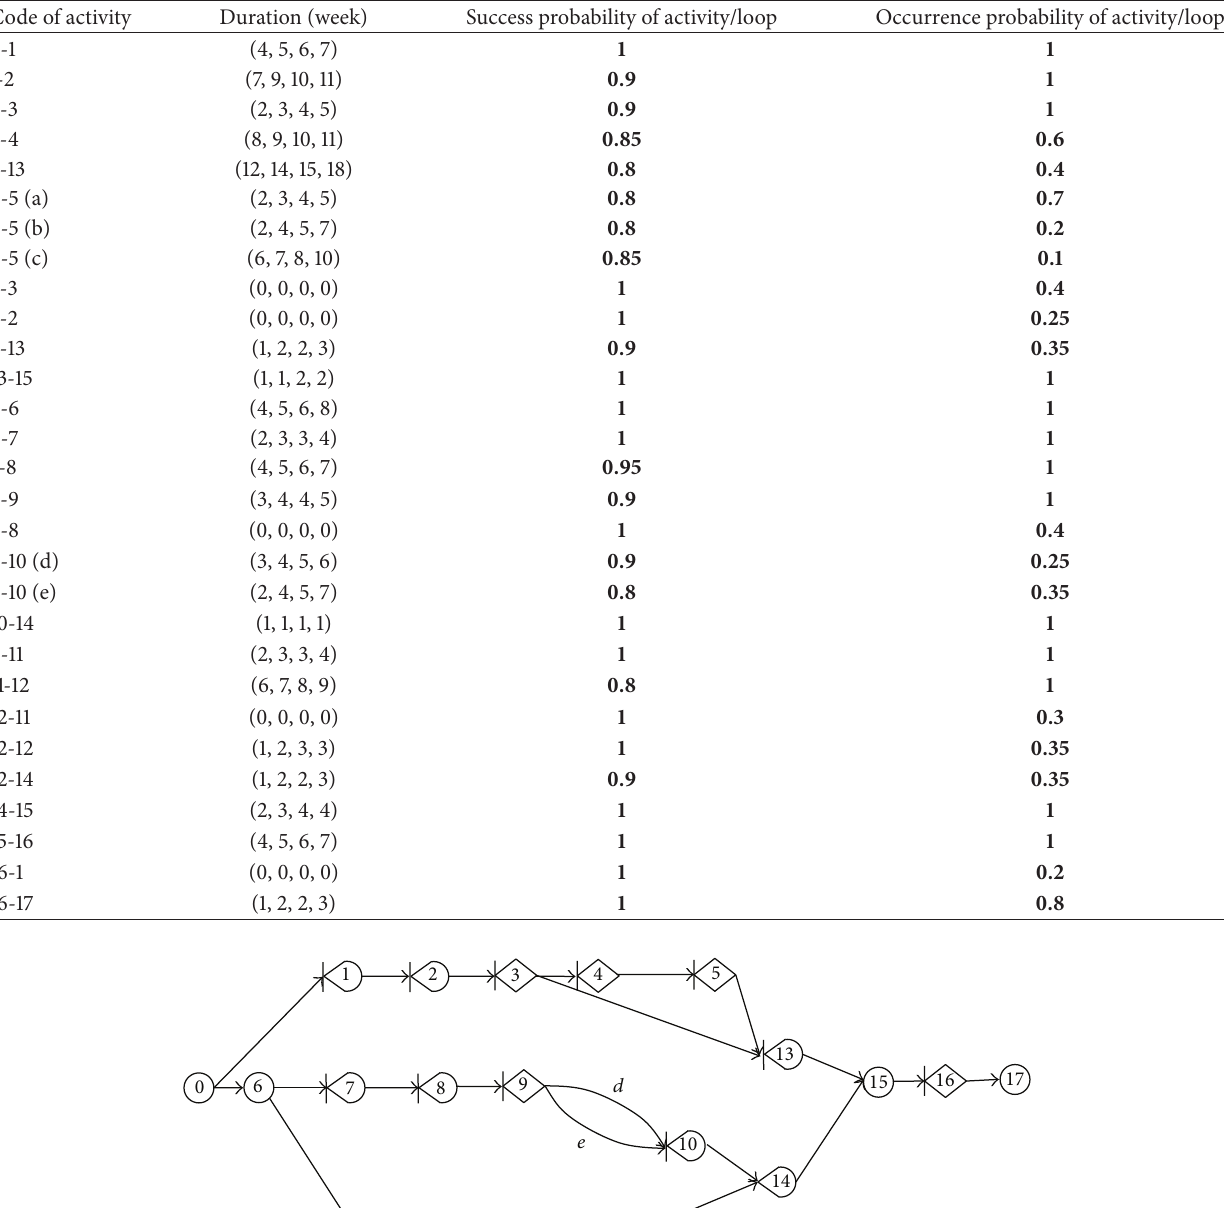
Table 4: Input parameters of activity network.